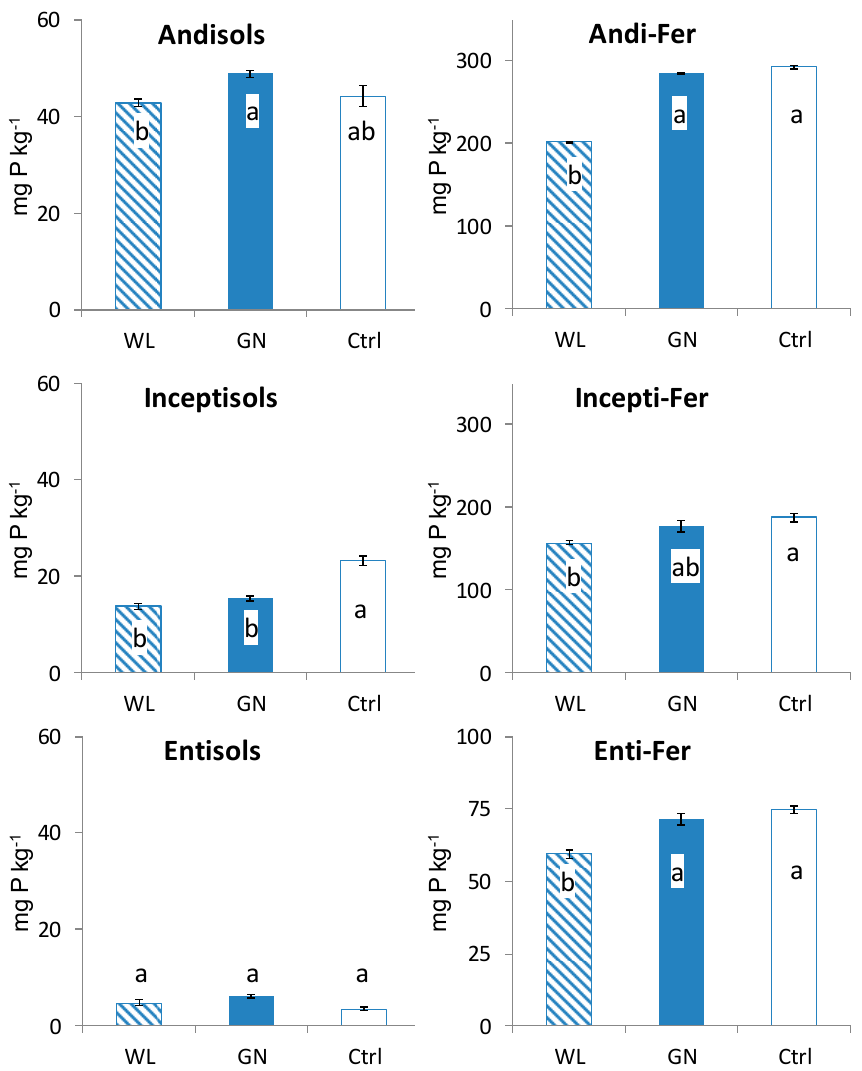
Figure 1. Labile P of white lupin (WL), groundnut (GN) rhizosphere soil, and of control (C trl ) soil. Labile P = Resin-P + NaHCO 3 -P i + NaHCO 3 -P o. Different letters indicate significant difference among WL, GN and C trl according to Tukey test ( p < 0.05).